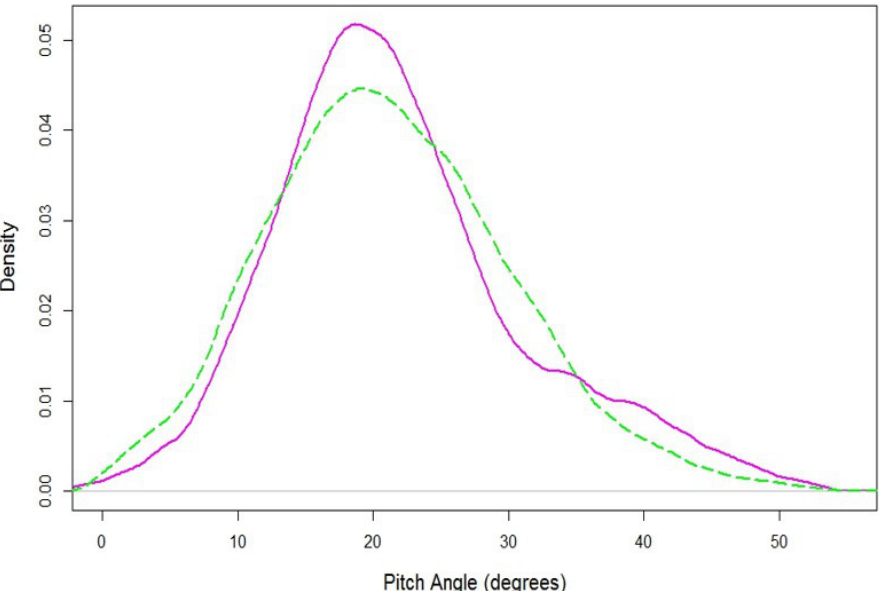
Figure 11. Comparison of initial kernel density estimator (KDE) fits of the probability densities for the Davis et al. [53] bright sample ( ) and our faint galaxies sample ( ). The faint galaxies sample has a slightly higher peak and heavier tail than its counterpart. Both distributions are strikingly similar at the lower pitch angle (higher mass) end of the function. The two functions reach peak probability density at nearly the same pitch angle. This graph was generated using the R package KEDD